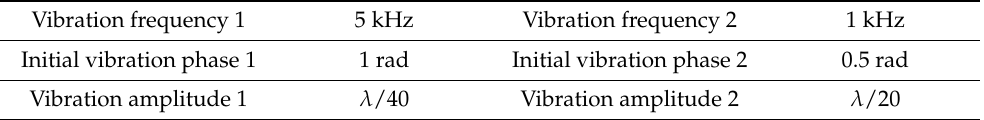
Table 2. Vibration parameters used in the simulation.